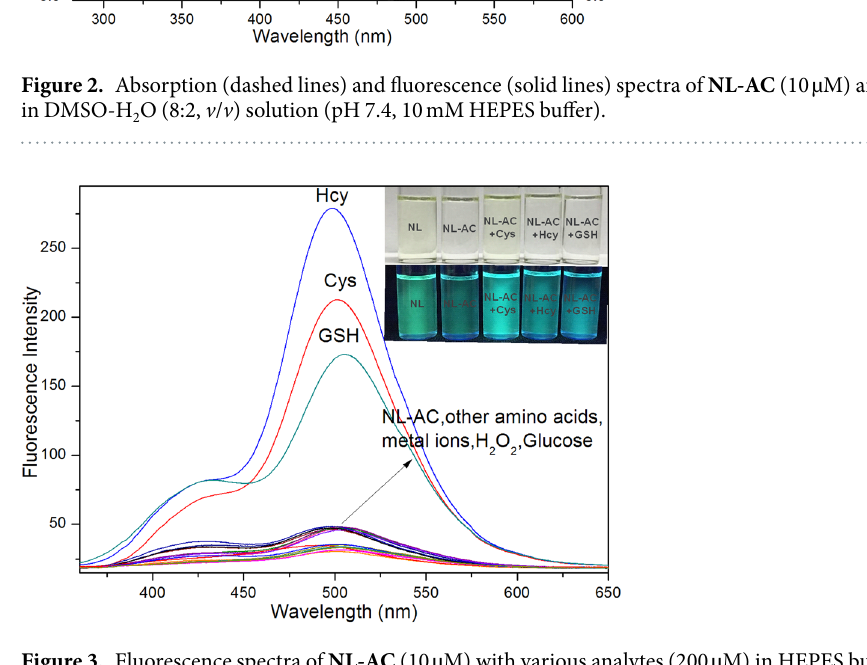
Figure 3. Fluorescence spectra of NL-AC (10 µ M) with various analytes (200 µ M) in HEPES buffer solution (DMSO/HEPES = 8:2, pH 7.4, λ ex = 336 nm, slit: 5.0 nm/5.0 nm). The inset is a photograph of NL-AC without and with biothiols under ambient lighting (upper) or UV irradiation